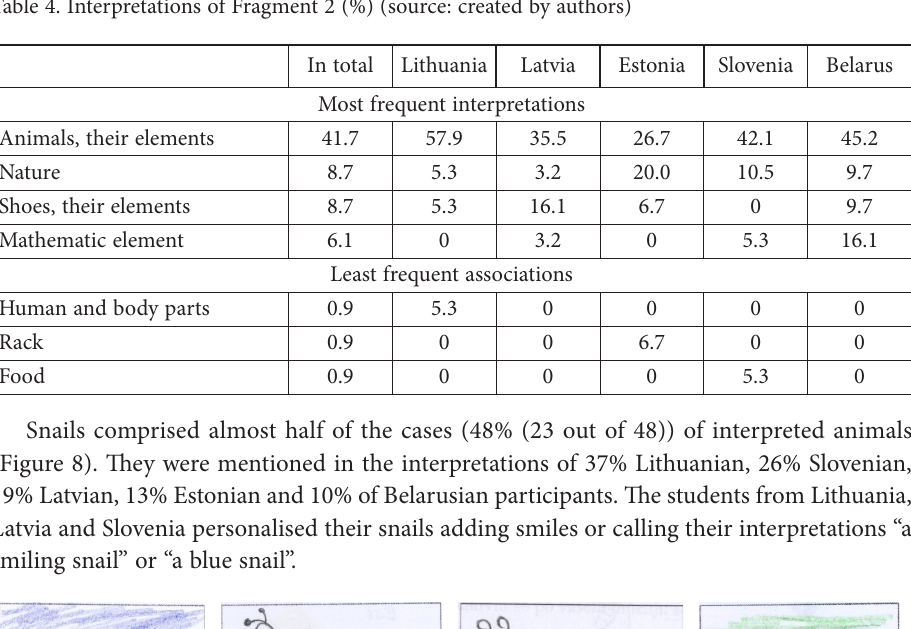
Table 4. Interpretations of Fragment 2 (%) (source: created by authors)